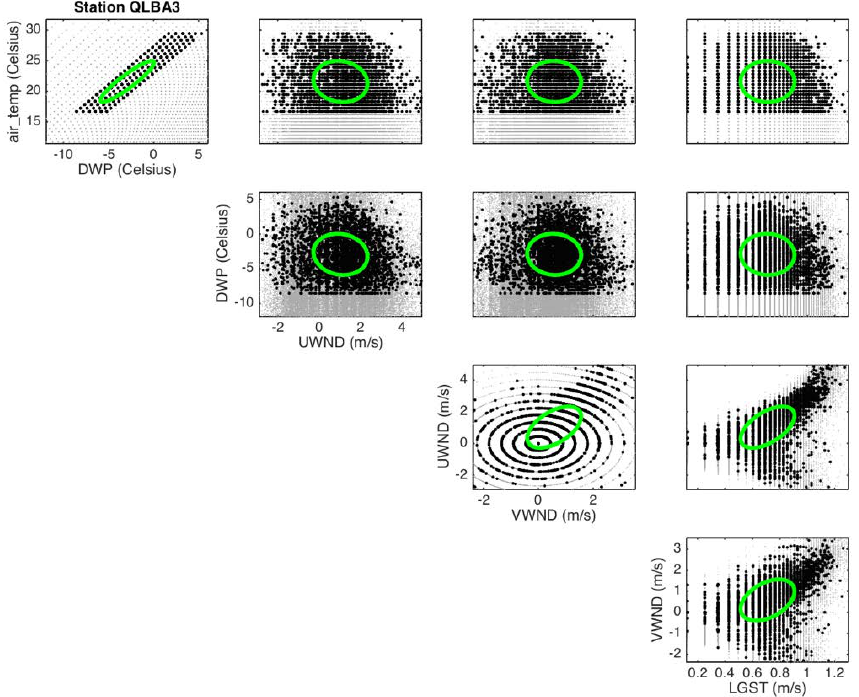
Figure A9. As in Figure 4 but for station